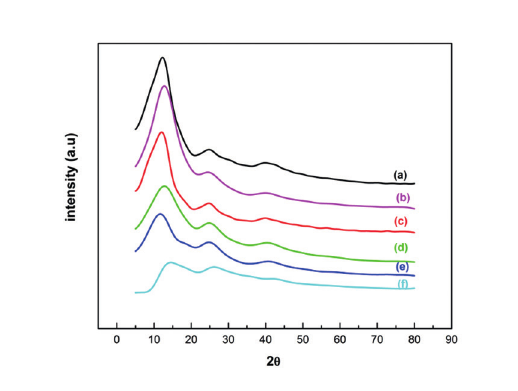
Figure 3: XRD patterns of PVC polymer films containing Mn 2+ (a) pure (b) 1mol% (c) 2mol% (d) 3 mol% (e) 4 mol% (f) 5 mol%.